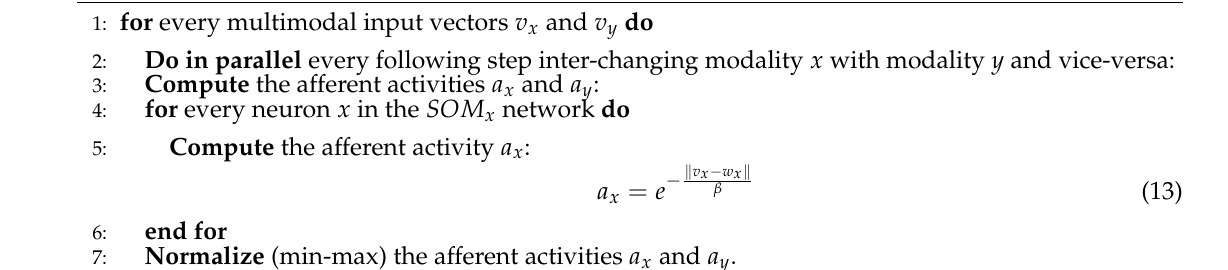
Algorithm 4 ReSOM convergence for